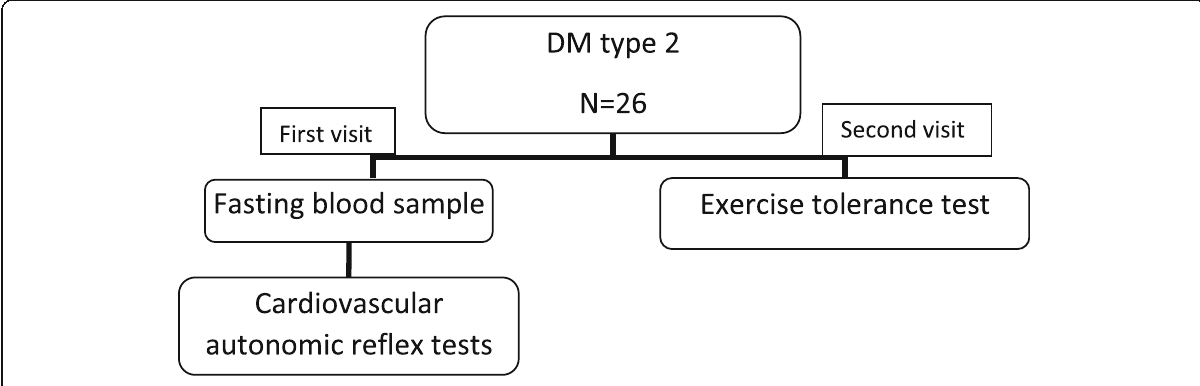
Fig. 1 Flow chart of the assessment of the